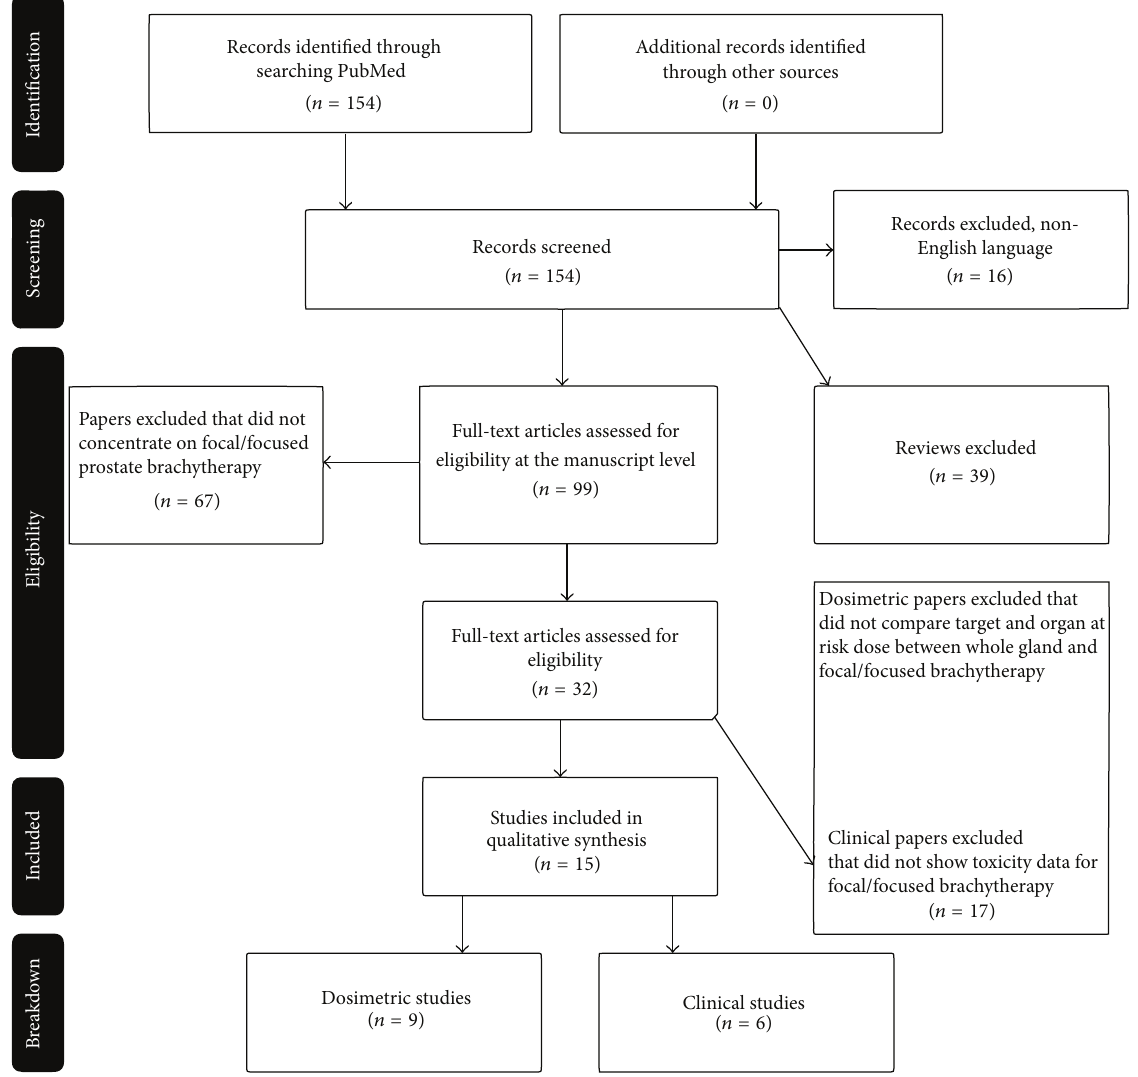
Figure 1: Literature selection process (PRISMA flow